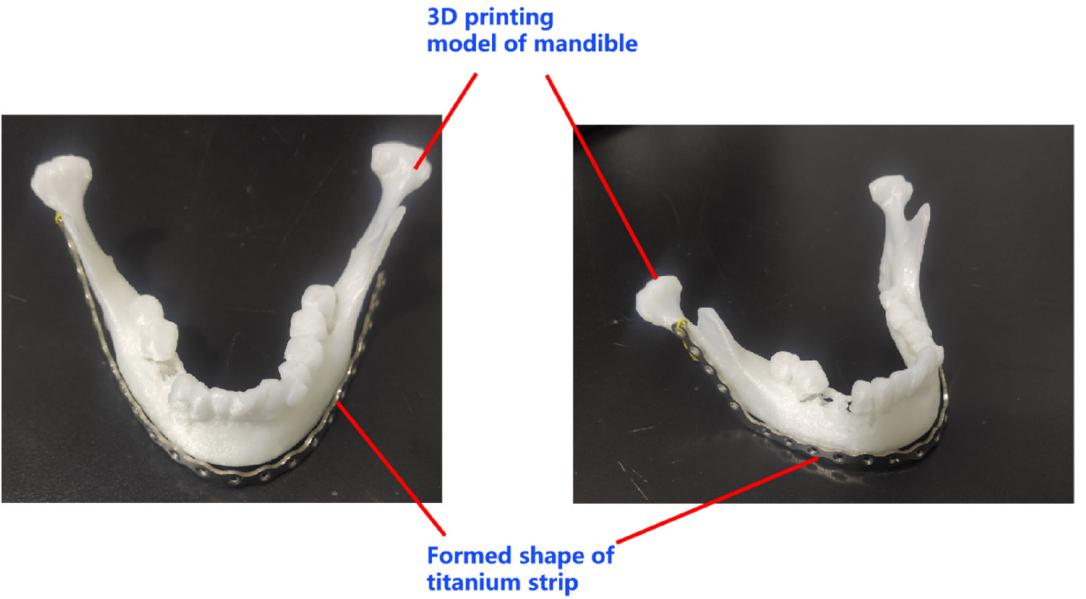
Figure 11. Overall reshaped titanium alloy strip.